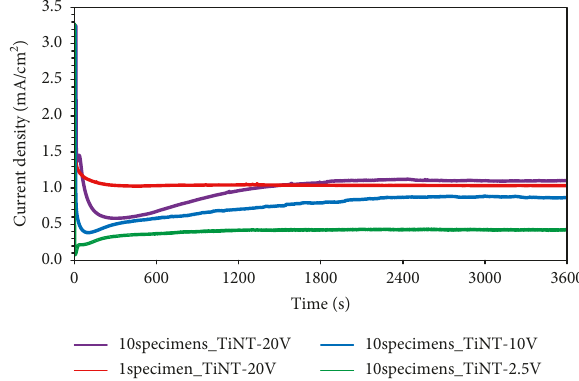
Figure 4: Current density recorded over time corresponding to the number of specimens per anodisation and their respective anod- ising